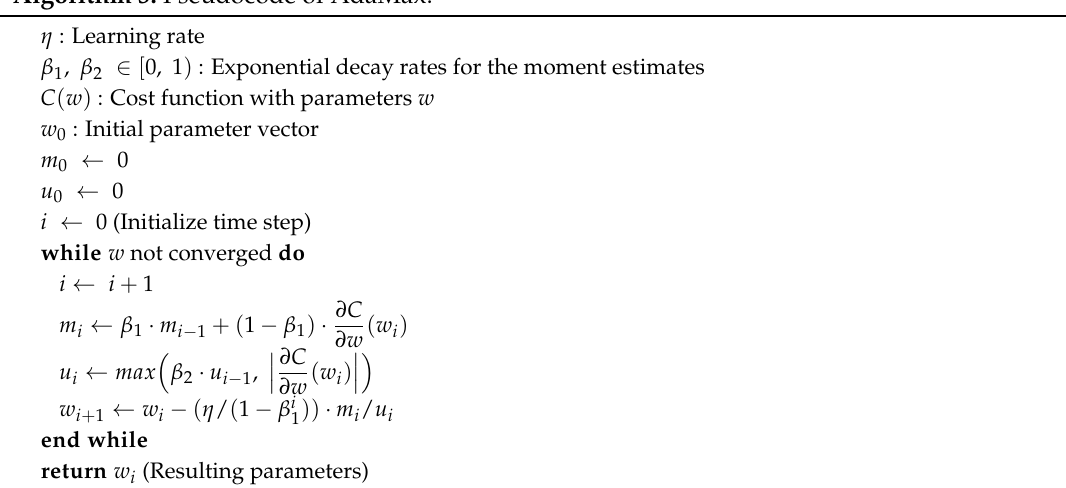
Algorithm 3: Pseudocode of